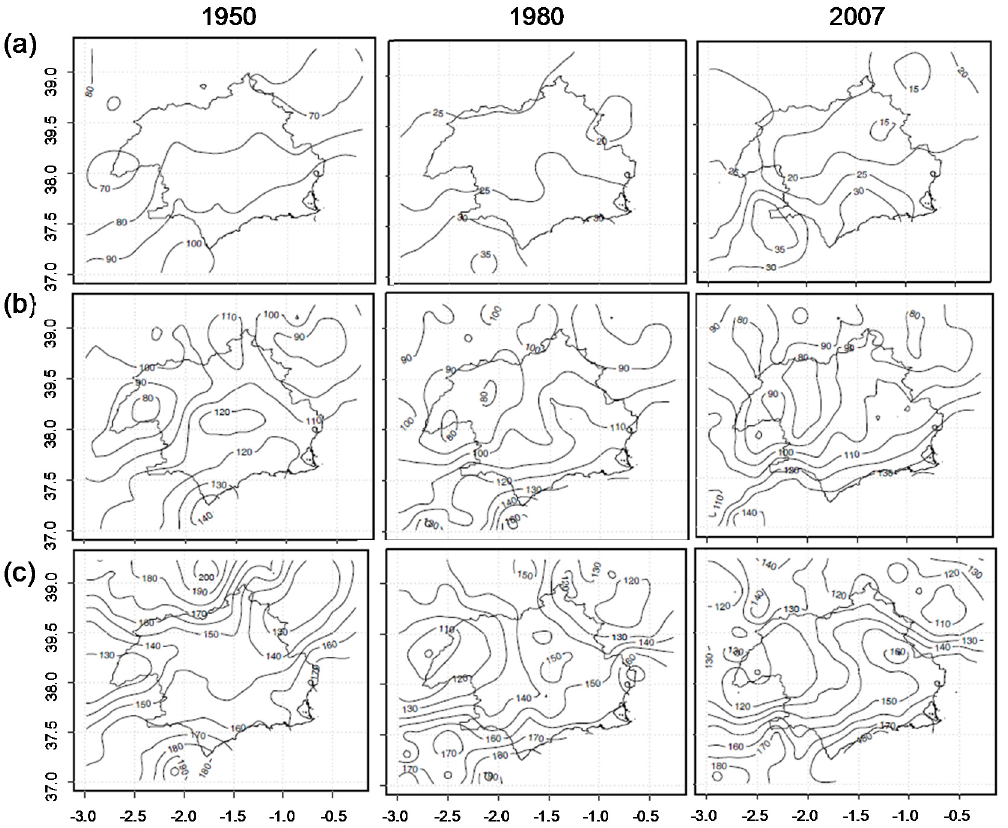
Figure 9. Spatial pattern of MDSL (days) from GAMLSS analysis on each site for Tr = 2 years and thresholds: ( a ) 1 mm/day; ( b ) 5 mm/day; ( c ) 10